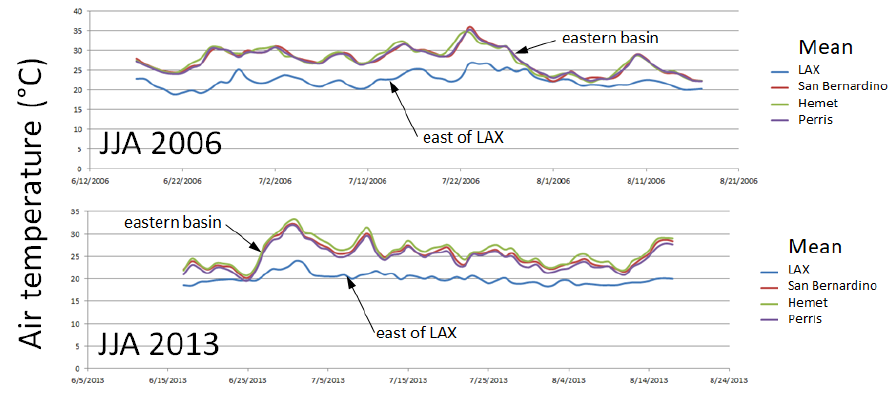
Figure 7. ( Top ) 2006; ( bottom ) 2013. Air temperatures at inland and coastal locations in the Los Angeles region based on PRISM data [47]. See text for discussion.